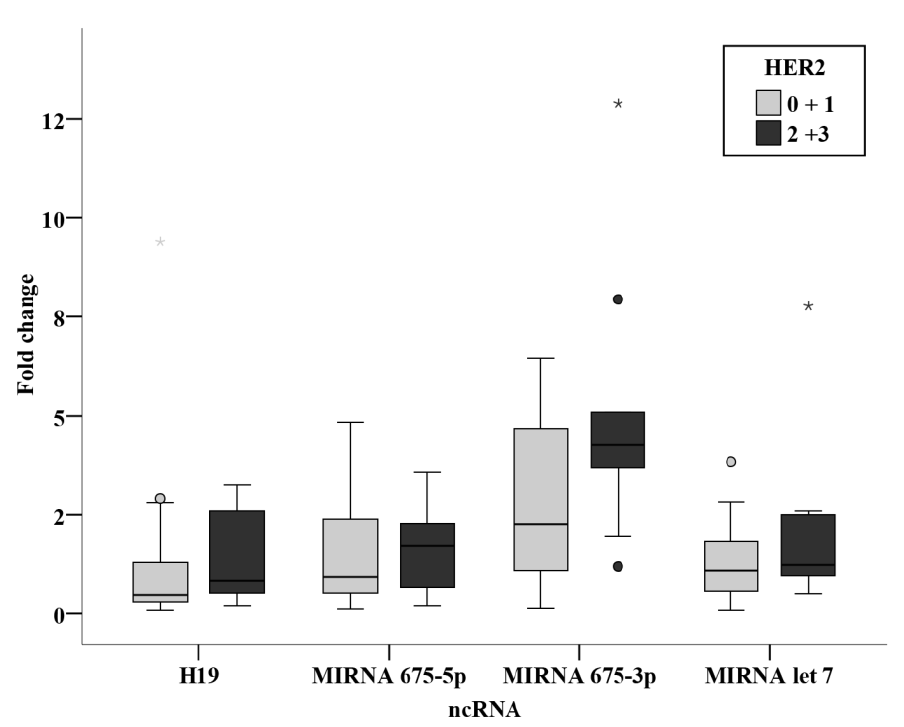
Figure 13. Relation between ncRNAs and PR status in the prechemotherapy BC patients. *—Extreme value.